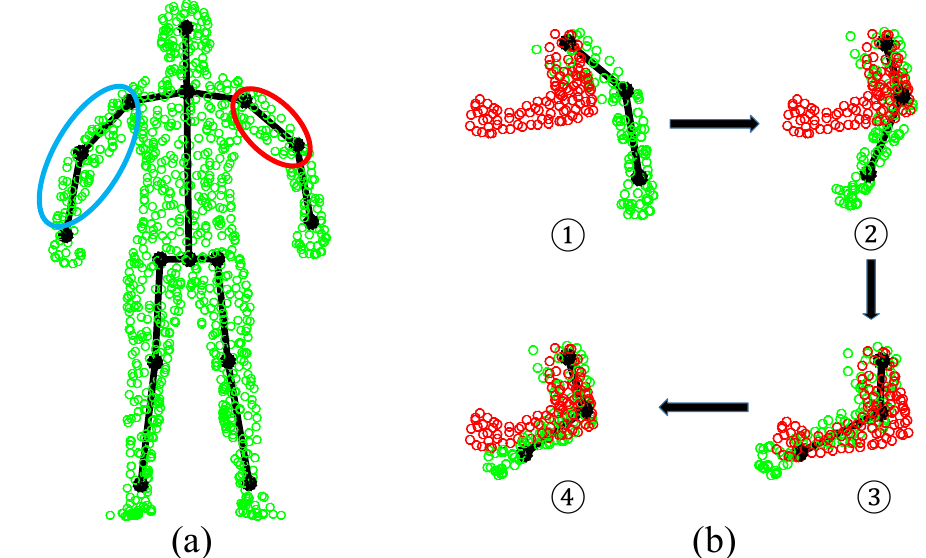
Figure 7. The illustration of the proposed segment-aware AICP (SAICP)-based registration algorithm. ( a ) Two examples to construct the rigid body part: selecting a single segment (red area) or several connected segments (blue area), which cannot be supported by the original AICP algorithm; ( b ) One example of transformation estimation of the left arm. (1) The template (green) and target (red) models; (2) The result of upper-arm deformation; (3) The result of lower-arm deformation; (4) The result of whole-arm